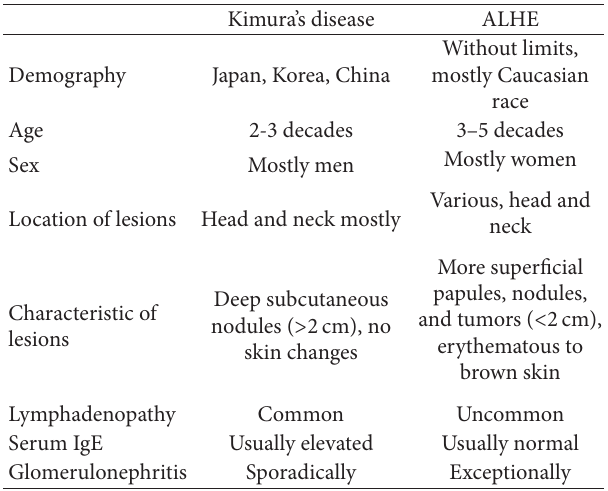
Table 1: Comparison of KD and ALHE.